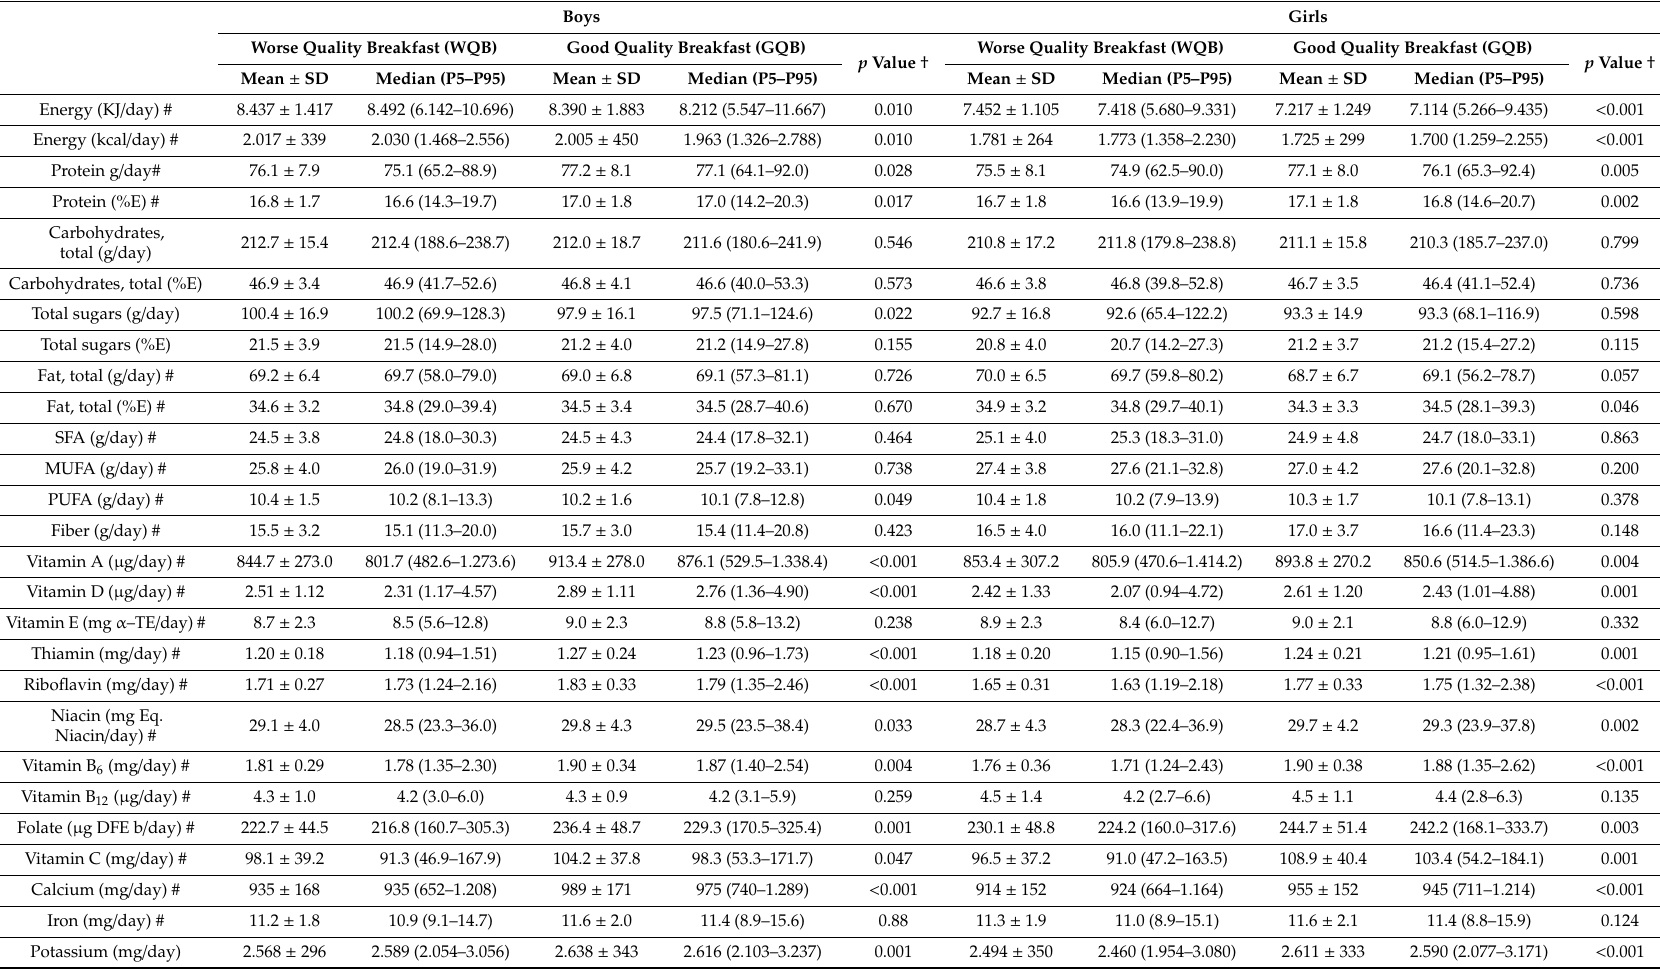
Table 7. Usual intakes (from food and beverage sources only) adjusted by energy of macronutrients and micronutrients in Spanish children and adolescents by sex and type of breakfast ( n =